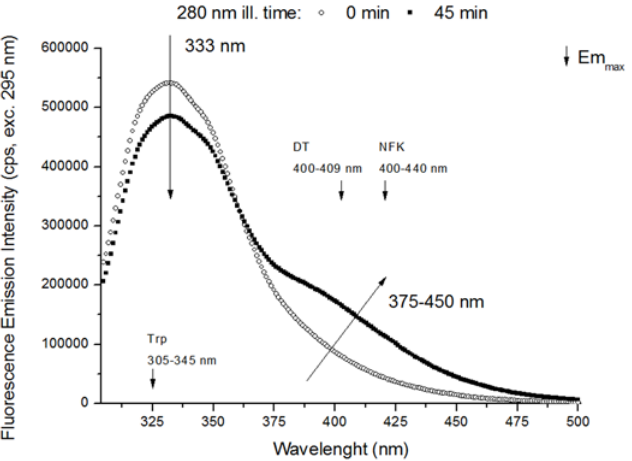
Fig 8. Fluorescence emission spectra of human plasminogen (295 nm excitation). Fluorescence emission spectra (295 nm exc.) recorded before and after 280 nm continuous illumination (45 min) of human plasminogen in solution. UV illumination of plasminogen results in a decrease in emission intensity at 330 nm and an increase in emission intensity between 375 nm and 450 nm. Small decreasing arrows indicate the wavelengths of maximum emission intensity (Em max ) of Trp, DT and NFK in